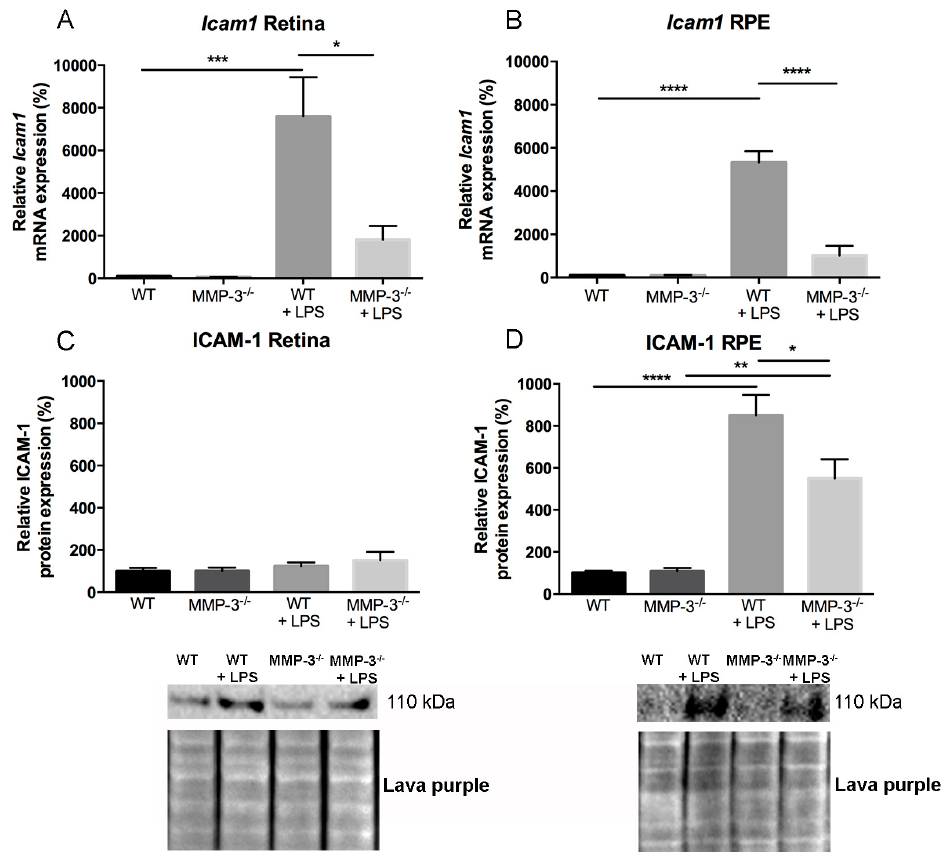
Figure 6. The effect of MMP-3 deficiency on ICAM-1 mRNA and protein levels in the retina and RPE during EIU. ( A , B ) Real time-PCR data revealed significantly elevated levels of Icam1 at 16 h after EIU induction in the posterior eye segment of WT eyes. This augmentation was significantly reduced in retinal and RPE samples of MMP-3 − / − mice as compared to WT animals. Data were normalized against the reference genes and were expressed as a percentage relative to 0 hpi ( n ≥ 3); ( C ) The protein level of ICAM-1 in the retina only showed a slight increase after EIU, and no clear difference between WT and MMP-3 − / − mice after LPS; ( D ) However, ICAM-1 in the RPE was significantly increased at 16 hpi in both genotypes. Interestingly, MMP-3 deficiency reduced ICAM-1 levels after LPS. Lava purple staining served as a loading control. Western blot data were normalized against Lava purple total protein stain and expressed as a percentage relative to 0 hpi. All data are shown as mean ± SEM, n ≥ 5, * p ≤ 0.05, ** p ≤ 0.01, *** p ≤ 0.001, **** p ≤ 0.0001. Data with no indicated statistical analysis point out no significant results.